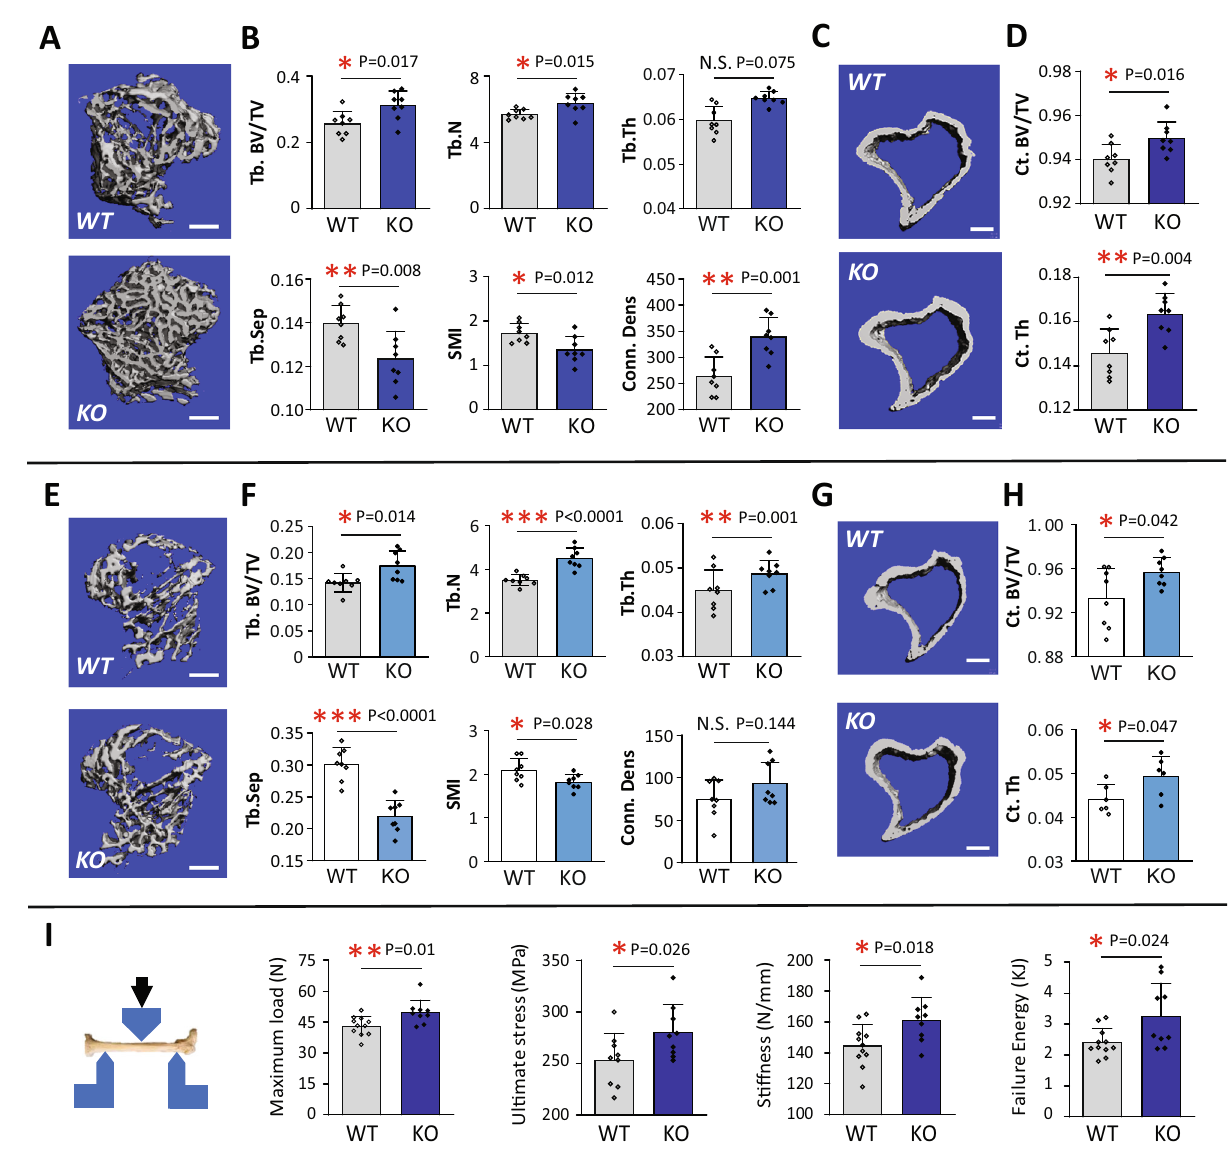
Fig. 3 | KIAA1199 KO mice exhibit increased bone mass and bone strength. A – H Bonemasswasdeterminedby µ CT-scanningoftrabecularbone( A , B , E , F )and corticalbone( C , D , G , H )onproximaltibiaof8weeksmale( A – D )andfemale( E – H ) KIAA1199 knockout (KO) and corresponding wild-type (WT) mice. Photo- micrographs of representative µ CT-3D scan are shown in ( A , C , E , G ), and quanti- tative data analysis are shown ( B , D , F , H ). Trabecular bone volume per tissue volume(Tb.BV/TV),trabecularthickness(Tb.Th.,mm),trabecularnumber(Tb.N., /mm 3 ), trabecular connectivity density (Conn-dens., /mm3), trabecular structure model index (SMI), trabecular separation (Tb.Sp., µ m), cortical (Ct) BV/TV, Ct